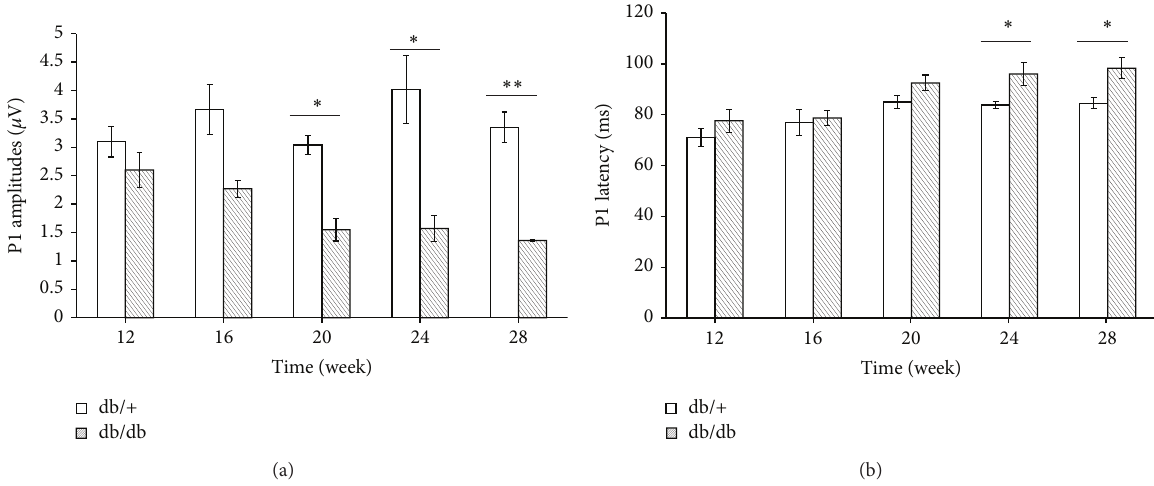
Figure 2: Abnormal changes in the PERG parameters of diabetic mice (db/db) were found at different week periods compared with nondiabetic mice (db/+). The P1 amplitudes and latency recorded from diabetic and control mice ( 𝑛 = 6 , resp.) were compared at each endpoint. db/db mice had an insignificant lower P1 amplitude than littermates at each point and showed significant amplitude reduction for 20 weeks (a). Significant delay of P1 latency was observed in db/db mice at 24 and 28 weeks (b). Data are expressed as mean ± SE. ∗ 𝑃 < 0.05 ; ∗∗ 𝑃 < 0.01 .